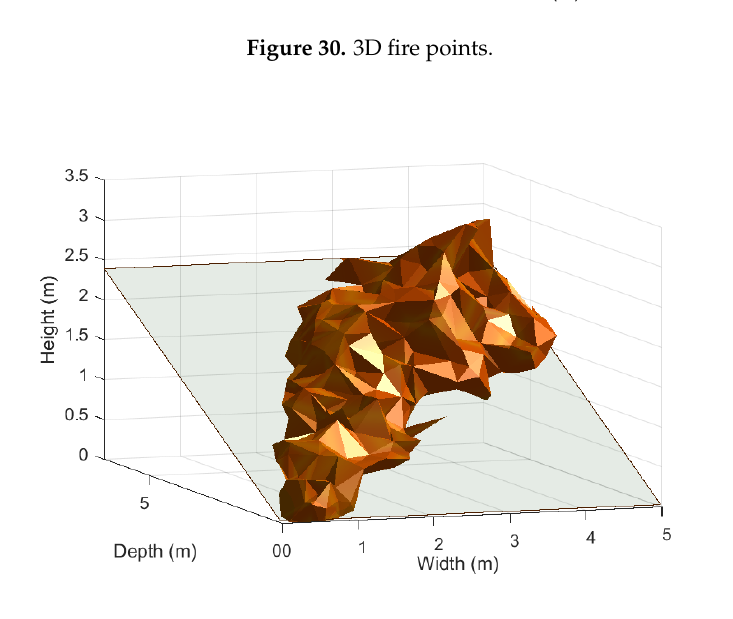
Figure 31. Estimated 3D reconstruction of the frontal part of the fire presented in Figure 28.